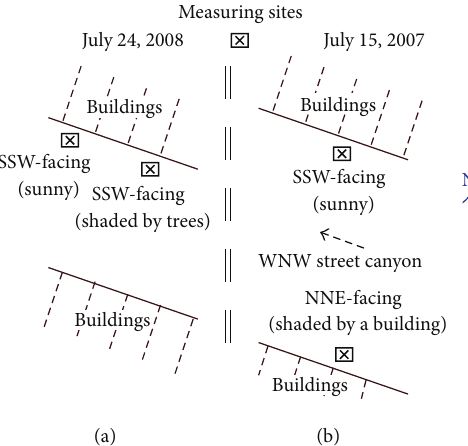
Figure 1: Location of the measuring sites during the human- biometeorological measuring campaigns within the same WNW street canyon in the “Vauban” quarter of Freiburg conducted on typical Central European summer days on July 15, 2007 (b) and July 24, 2008 (a).